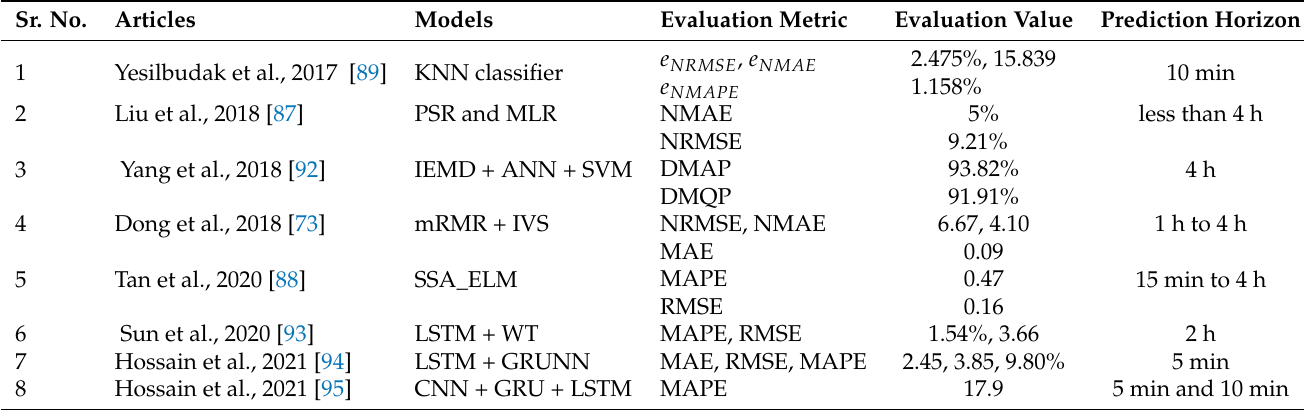
Table 9. Ultra short-term wind power